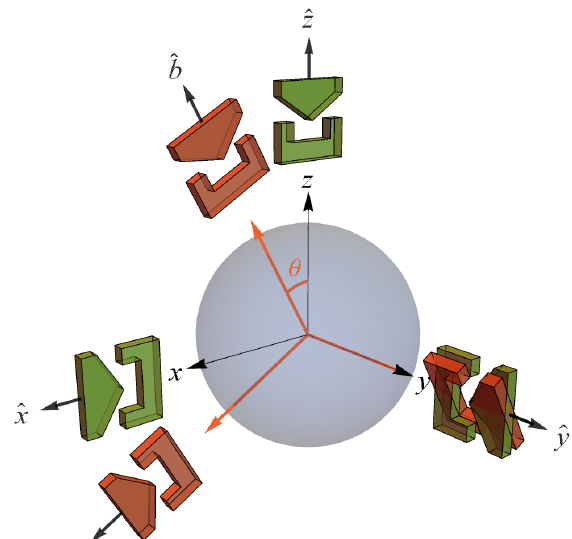
Figure 2: Two reference frames related by SO(3) each associ- ated with a set of mutually complementary SG spin measure- ments [23]. Reproduced from Stuckey et al.